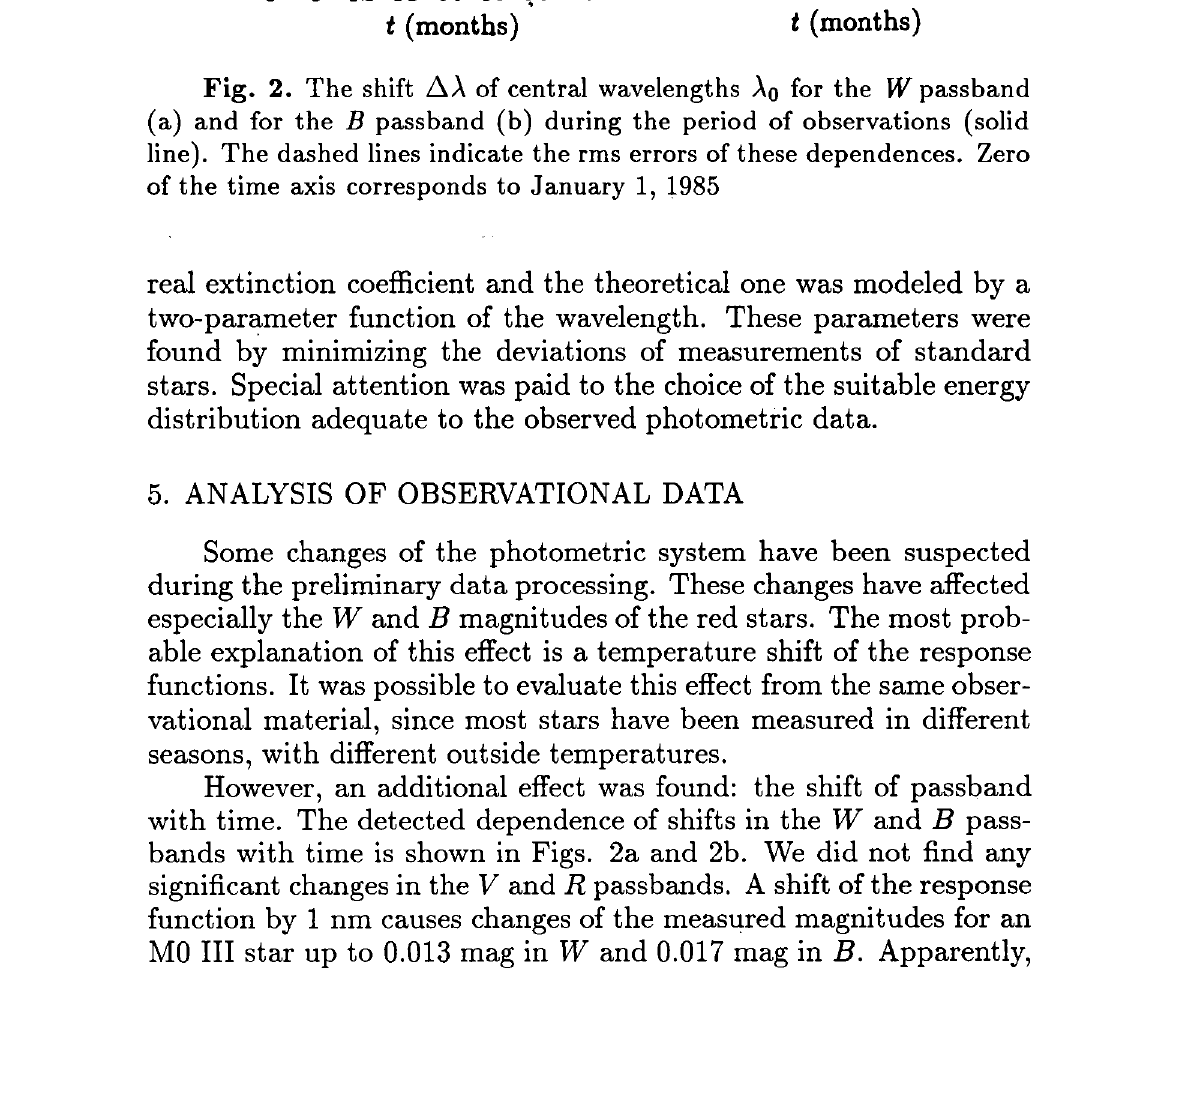
Fig. 2. The shift AA of central wavelengths Ao for the passband (a) and for the B passband (b) during the period of observations (solid line). The dashed lines indicate the rms errors of these dependences.